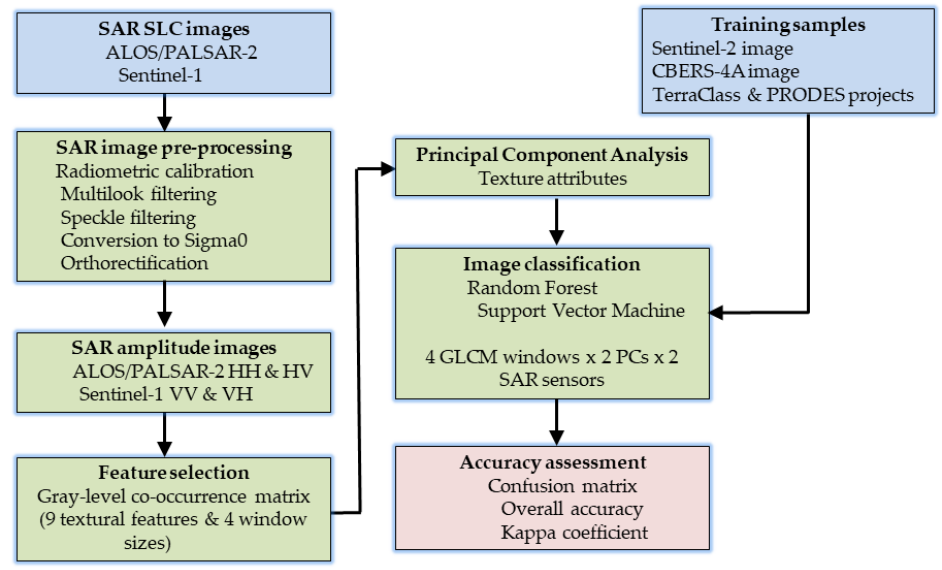
Figure 2. Flowchart showing the main steps of the methodological approach considered in this study.